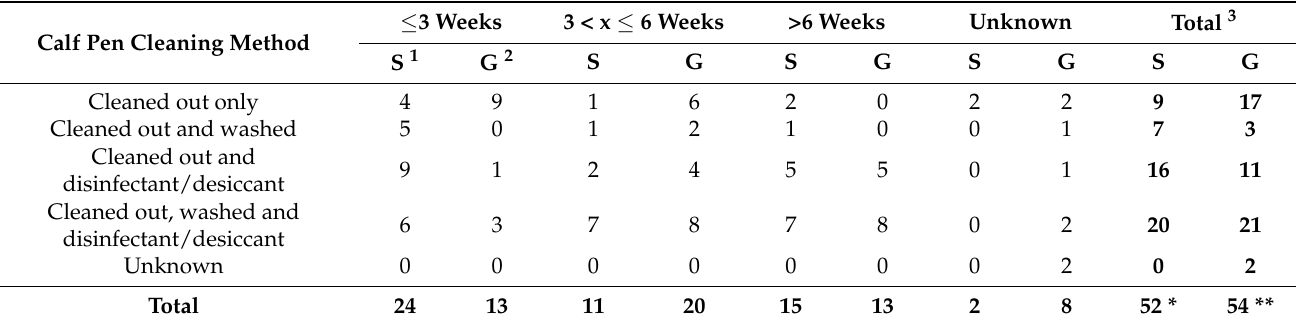
Table 2. Distribution of 66 farms according to the method and frequency of cleaning single and group calf